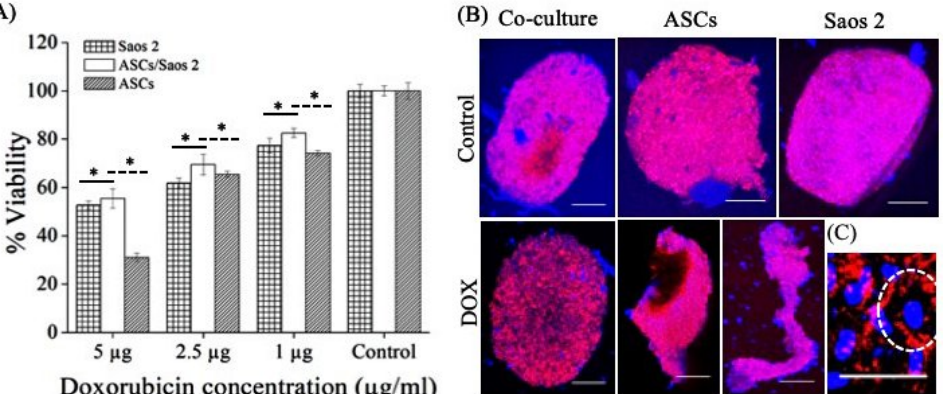
Figure 5. Effect of doxorubicin treatment on ( A ) cell viability ( p < 0.1) and ( B ) actin arrangement within tumorspheres and ASC spheres. ( C ) Cells exhibiting cortical actin cytoskeleton indicated with white dashed circle. Scale bar = 250 μ m.